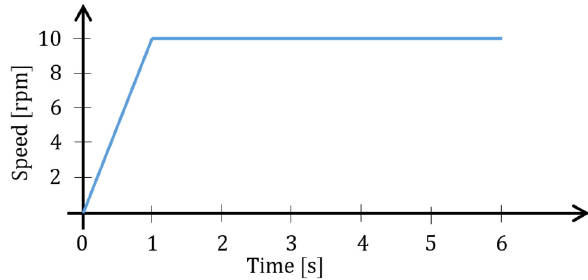
Figure 9. Angular velocity profile assigned to driver gear.